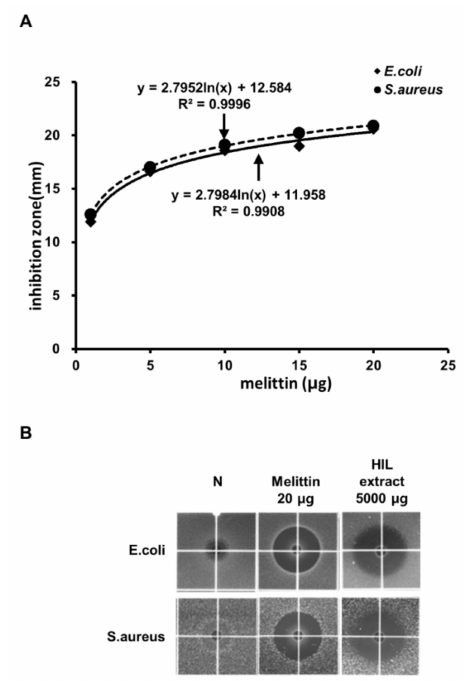
Figure 2. Determination of the amount of defatted HIL extract that corresponds to the antimicrobial activity of melittin. ( A ) Standard curve of the inhibitory zone with various amounts of melittin against E. coli and S. aureus . The inhibitory zone was measured as the diameter of the clear circular zone. Standard curve was presented by natural logarithmic trendline calculated by Excel in Microsoft Office 16. ( B ) Comparison of the antimicrobial activities of melittin and defatted HIL extract. Each sample was dissolved in 0.05% acetic acid solution, and 10 µ L of the extract was loaded into the wells in the underlay gel and incubated for 24 h to determine antimicrobial activity using RDA. N: 0.05% acetic acid